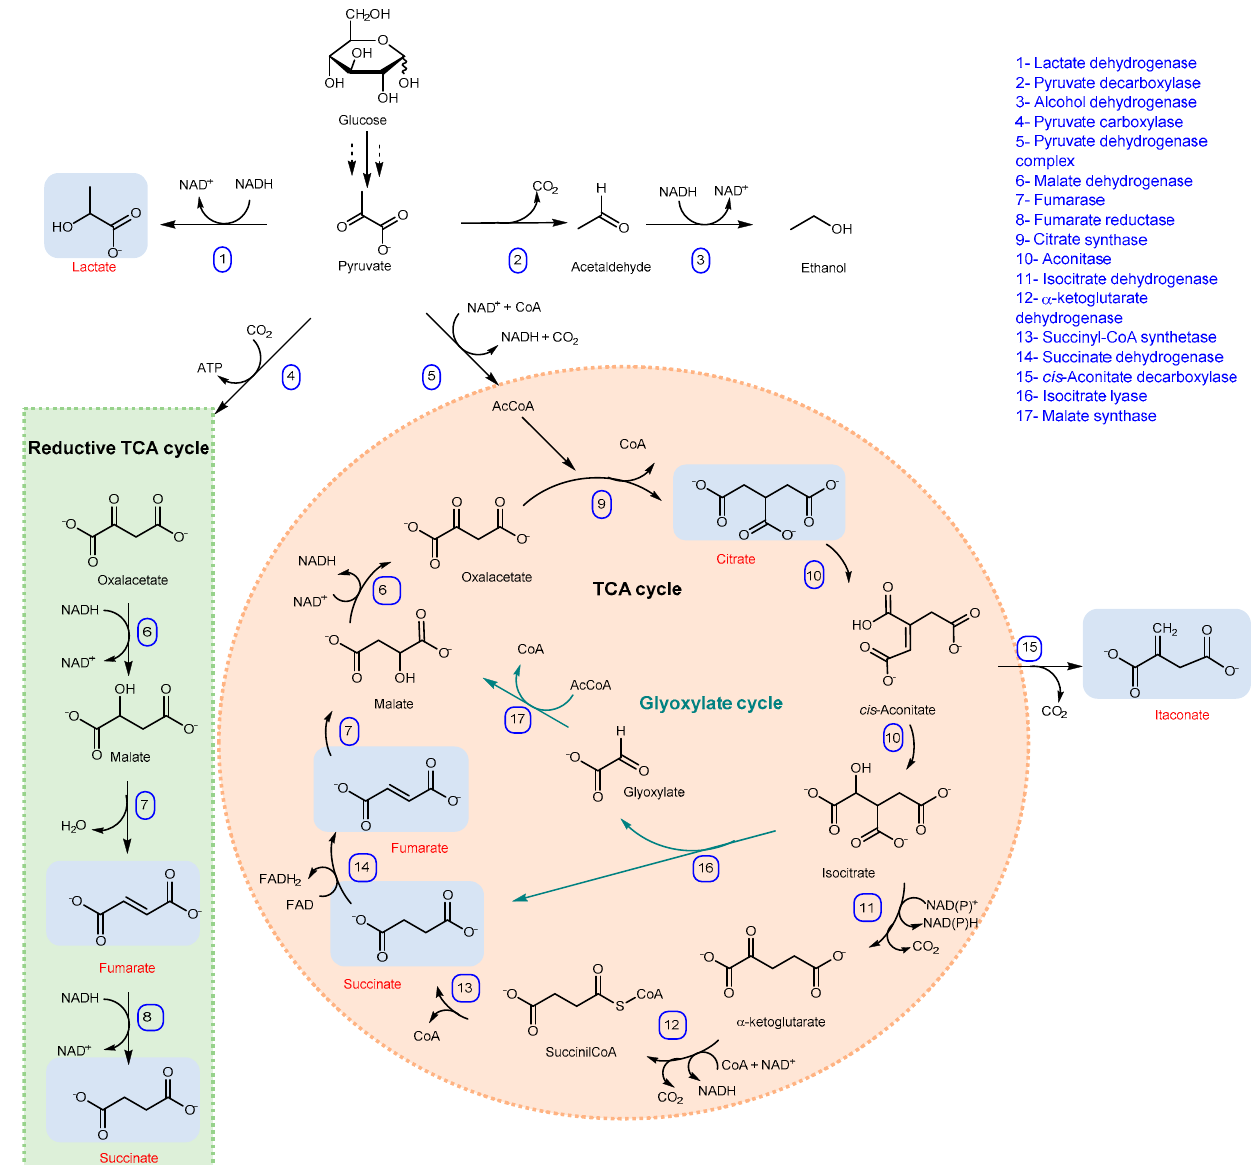
Scheme 2. Representation of the main metabolic pathways involved in the production of citric, fumaric, itaconic, lactic and succinic